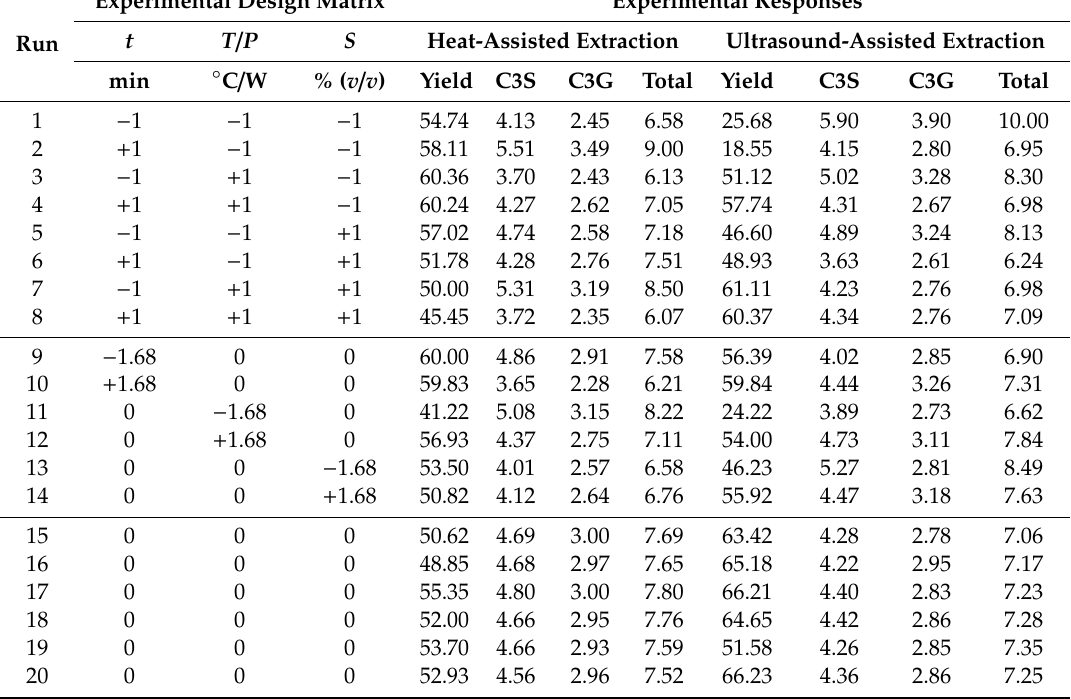
Table 2. Experimental responses obtained under the extraction conditions defined in the RCCD design matrix for the extraction yield (%, w / w ) and contents of cyanidin-3- O -sophoroside (C3S, mg / g extract), cyanidin-3- O -glucoside (C3G, mg / g extract) and the sum of both anthocyanins (total, mg / g extract) as a function of the extraction method. The natural values of the independent variables are presented in Table